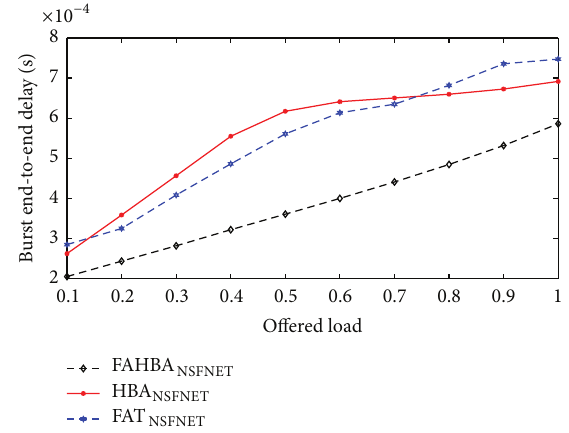
Figure 8: Burst end-to-end delay versus offered load.